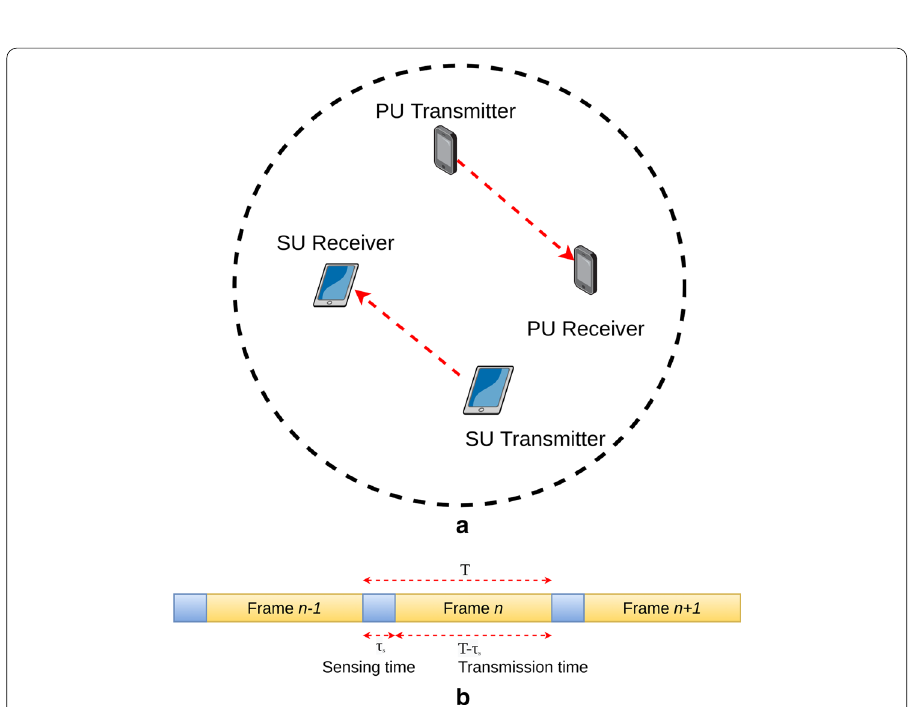
Fig. 1 a System model. b SU frame [3,